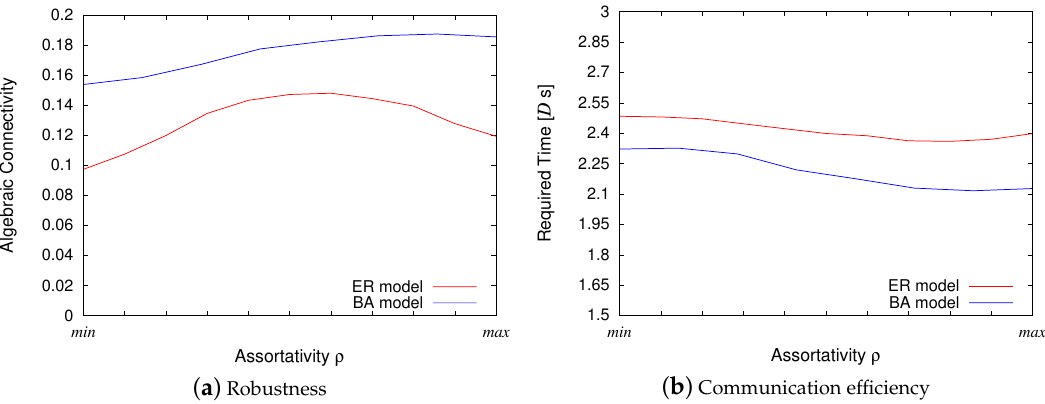
Figure 6. Simulation results for 4-module networks. ( min , max ) corresponds to ( − 0.05, 0.05) and ( − 0.04, 0.10) for the ER and BA models,